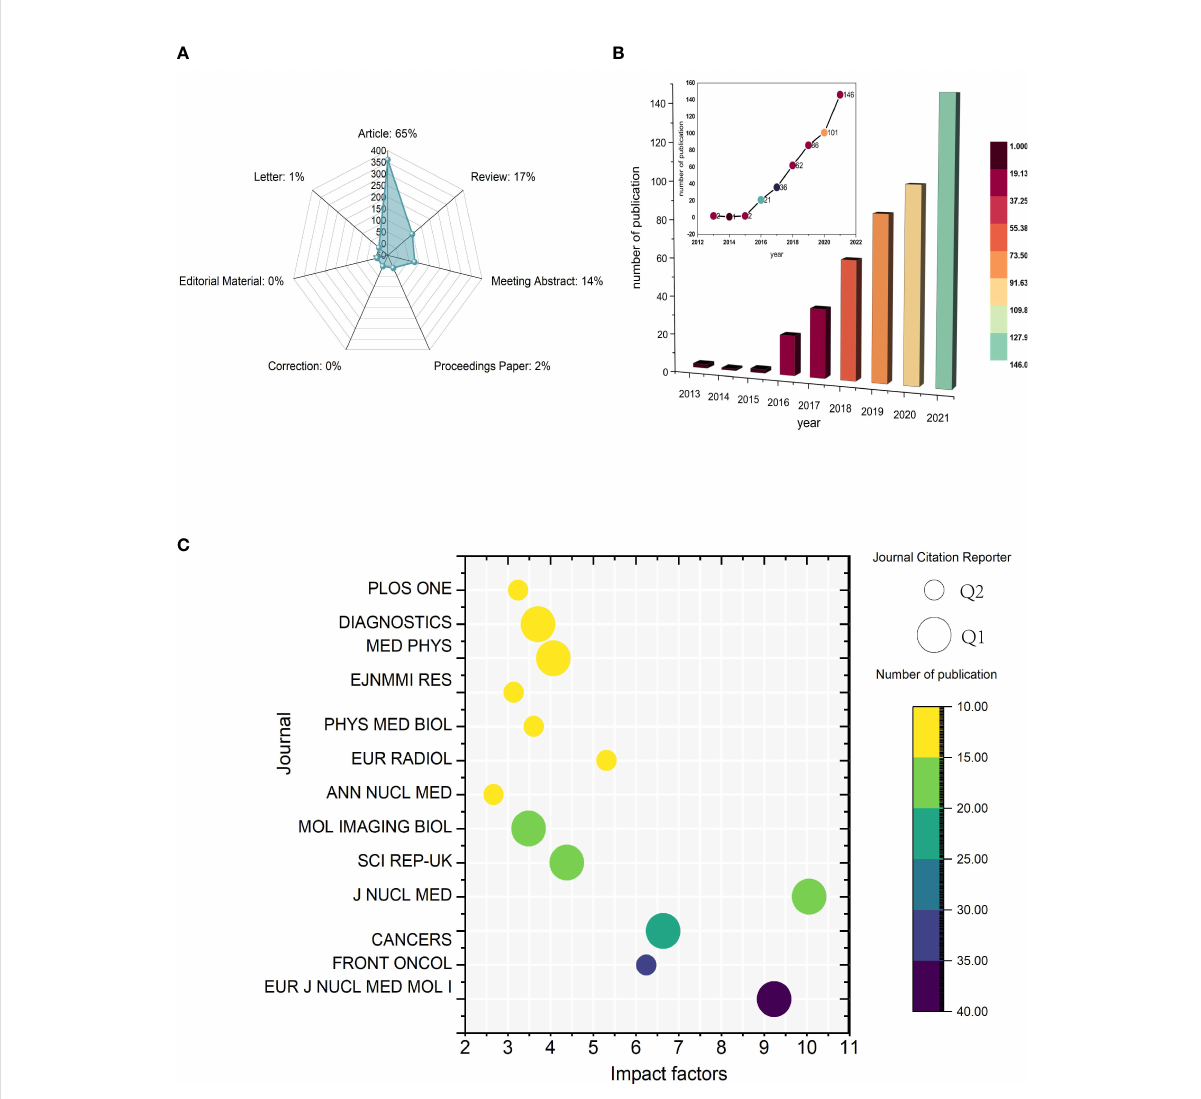
FIGURE 2 Temporal trends of publications of 18 F-FDG PET/CT radiomics research. (A) Category of all published literatures. (B) Annual publications and temporal trends of 18 F-FDG PET/CT radiomics research. (C) Bubble plot of journals with more than 10 publications. The size of bubbles represents classi fi cation from Journal Citation Reports and the colors are related to the number of